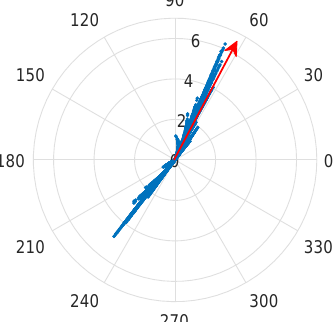
Figure 5. Tidal velocity in polar coordinates.